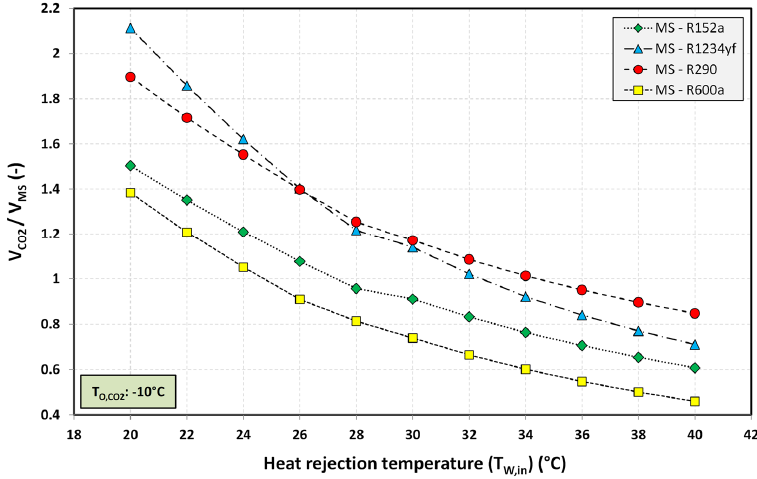
Figure 14. Compressor capacity ratio at the optimal operating conditions vs. heat rejection pressure.